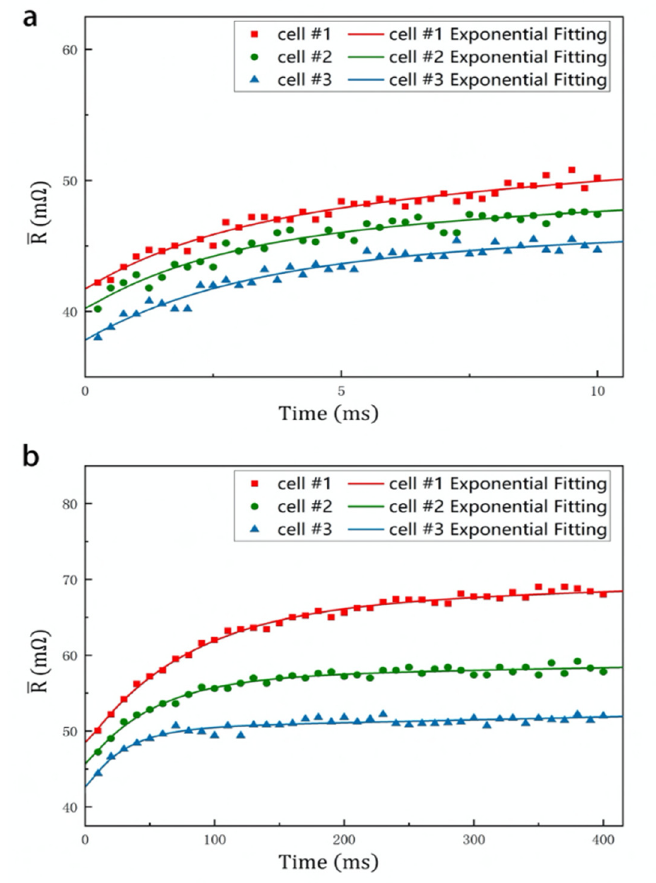
Figure 4. DCIS measurement for cell #1 (2650 mAh), cell #2 (2850 mAh) and cell #3 (3050 mAh). ( a ) High frequency RC network DCIS. ( b ) Low frequency RC network DCIS.